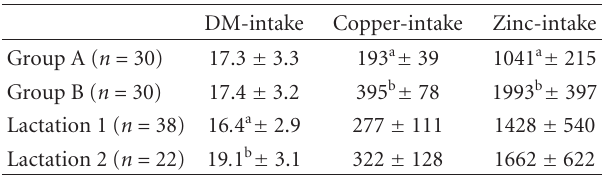
Table 3: Mean dry matter (DM)-intake (kg/d) as well as copper and zinc intake